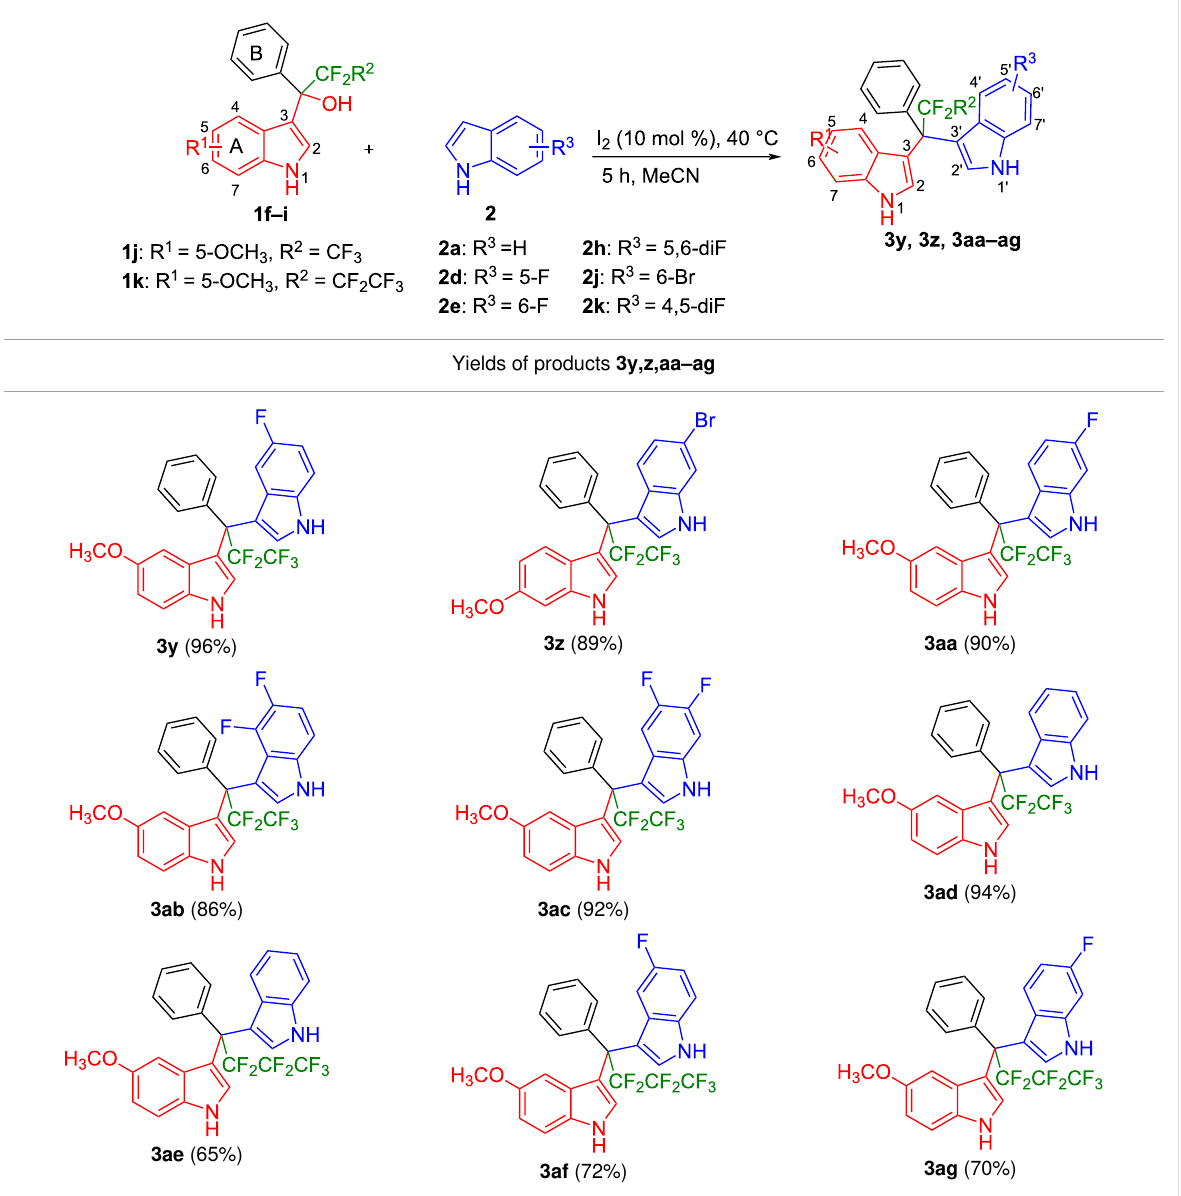
Table 4: Substrate scope of the reaction of 1j – l with trifluoromethyl(indolyl)phenylmethanols 1 : modification of the trifluoromethyl group.